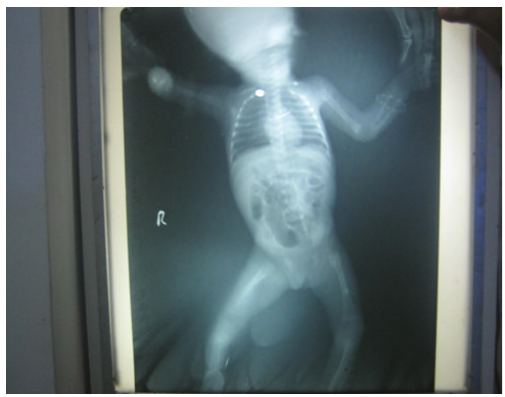
Figure 3: Radiograph showing lower end of humerus (periostitis) and proximal ends of radius and ulna